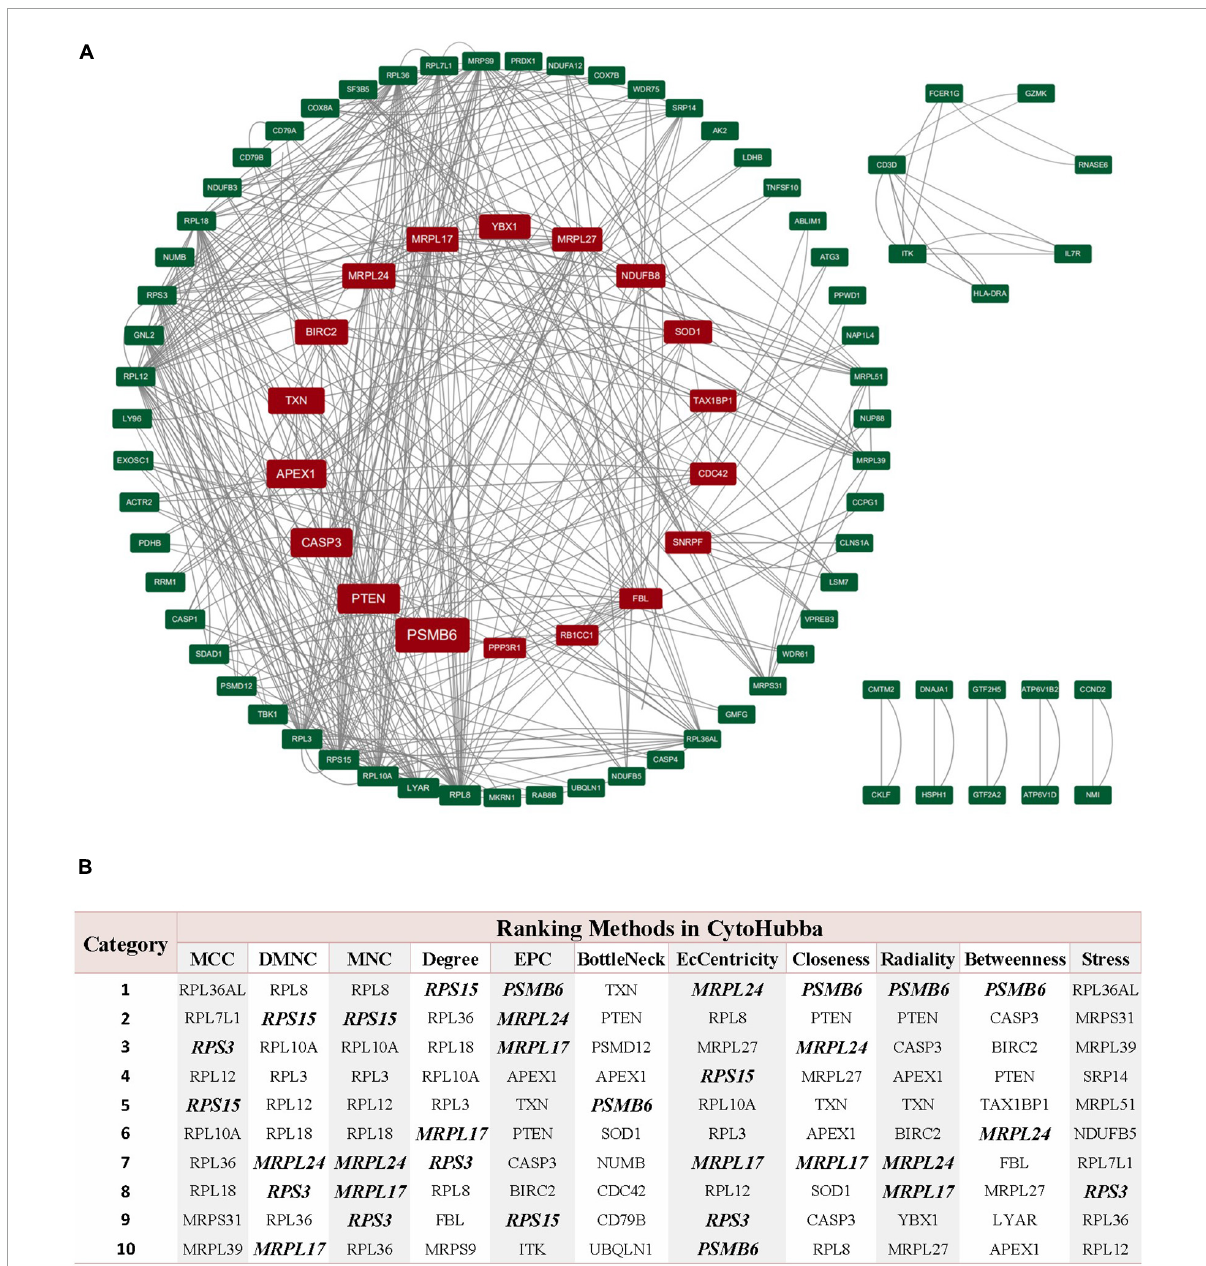
FIGURE4 PPI network of common DEGs shared by AD and IS. (A) The circle nodes represent DEGs and edges represent the interactions between nodes. The PPI network has 65 nodes and 564 edges. (B) According to the 11 ranking methods provided by CytoHubba app, top 10 genes by at least 6 methods are referred as hub genes. Five hub genes were italicized and bold and the scores from all methods were labeled in